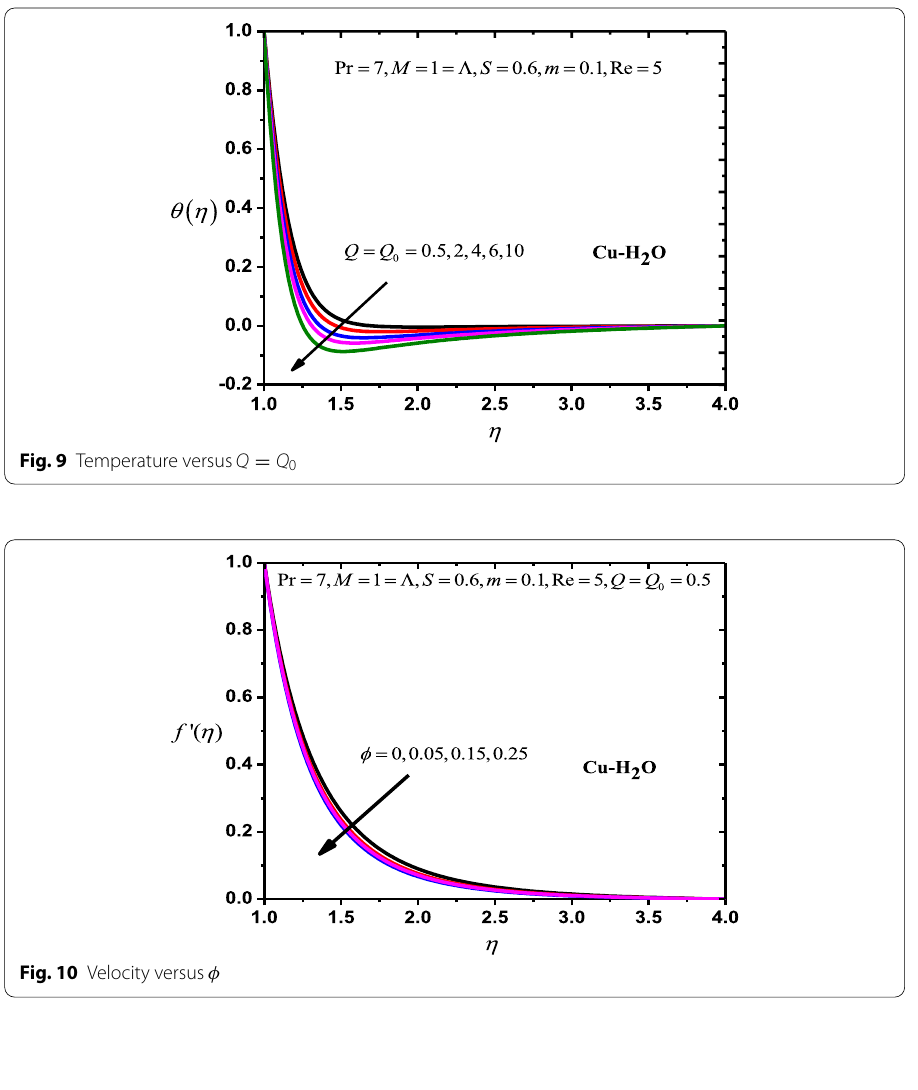
Fig. 10 Velocity versus φ